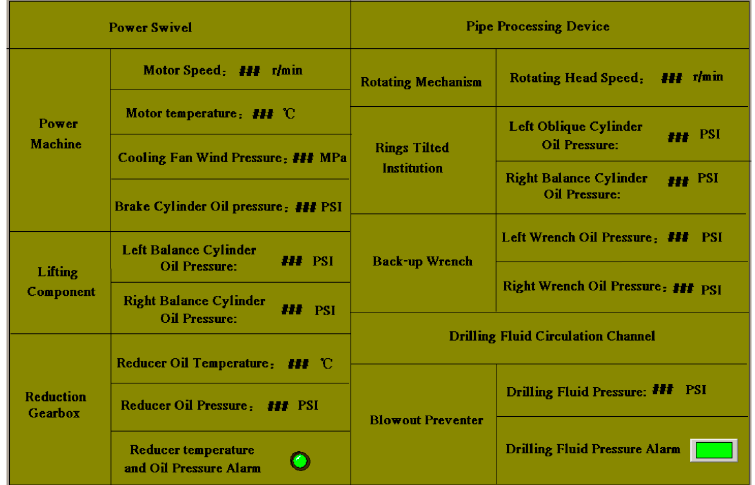
Figure 6. Monitoring configuration screen of top drive.